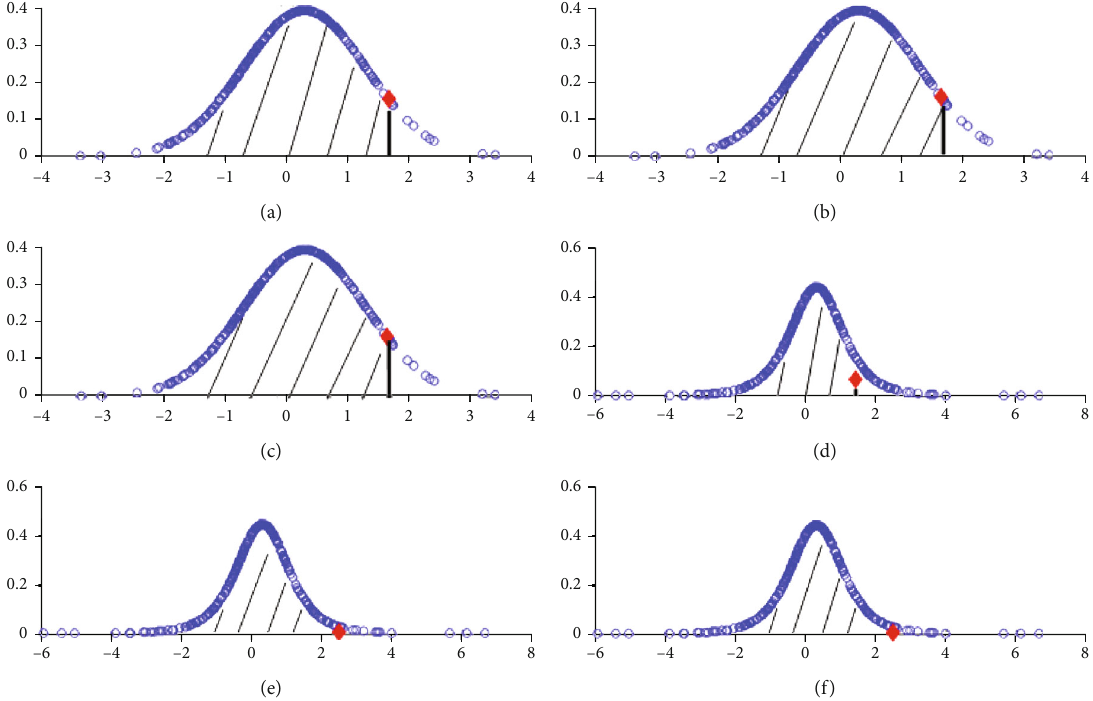
Figure 4: Quantile-based VaR forecast (the red dot mark) of normal (left column) and t (right column) distributed data obtained from bivariate normal (a) and t (d) distributions. The implicit copulas (Gaussian and t ) are shown in (b) and (e), respectively, whilst the use of Clayton copula (explicit copula, member of Archimedean copula) is shown in (c, f),